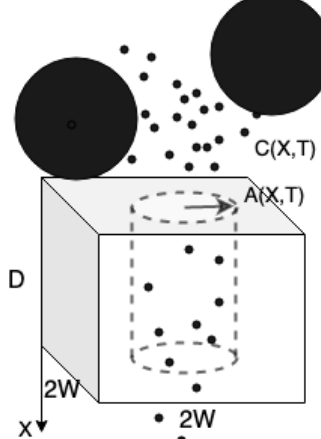
Figure 2. This is a schematic, showing the single unit of a membrane, which is assumed repeated in a square lattice. Two species of particles are indicated here: (i) small particles and (ii) large particles. Small particles, at concentration C ( X , T ) , enter the pore and deposit within. Large particles block the pore